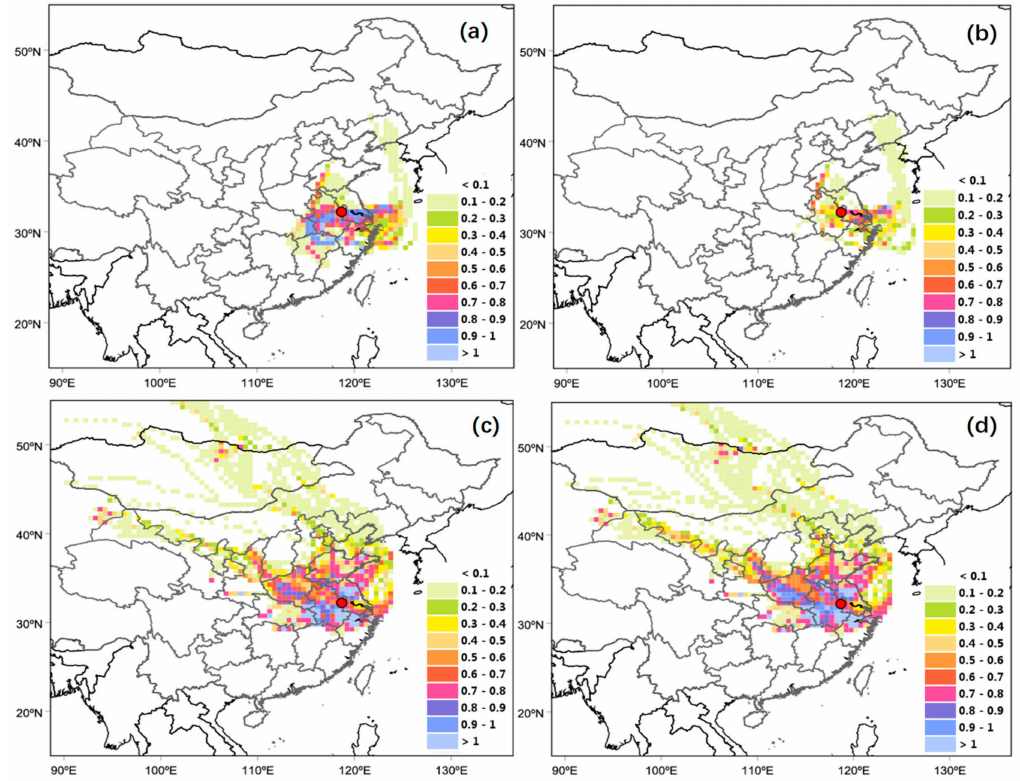
Figure 8. Potential source contribution function (PSCF) maps for particulate matter, PM 2.5 ( a ) summer, ( c ) winter and PM 10 ( b ) summer, ( d )